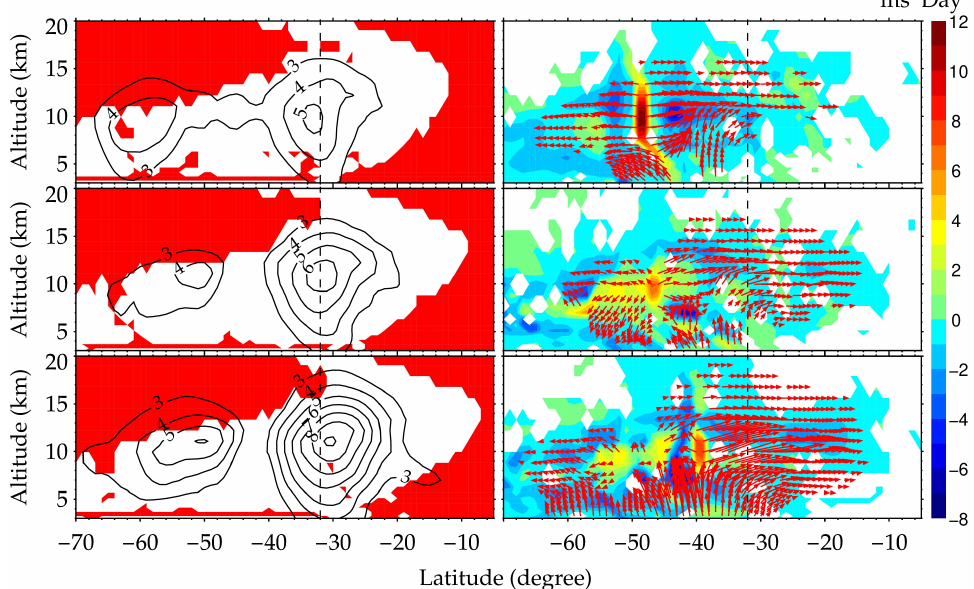
Figure 10. Latitude–altitude sections of the refractive index squared ( left panels ) and the EP flux ( right panels ) for the E5 10DW on 24 April ( top row ), 30 April ( middle row ) and 6 May ( bottom row ). In the left panels, regions with a negative refractive index squared are shaded in red, and the black contours denote the zonal wind amplitudes of the E5 10DW. In the right panels, regions with significant EP flux divergence or convergence are represented by colored contours, and the red vectors denote EPX and EPZ. The dashed vertical lines denote the latitude of 32 ◦